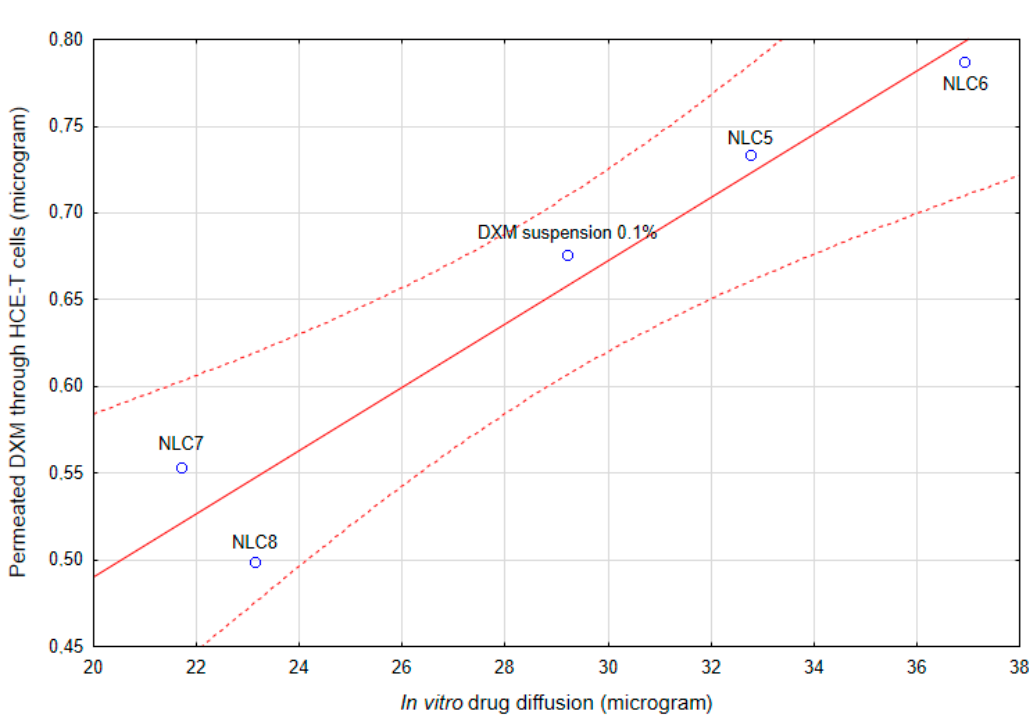
ff usion study and HCE-T cell line Figure 15. The correlation of the in vitro diffusion study and HCE-T cell line permeability. Figure 15. The correlation of the in vitro di